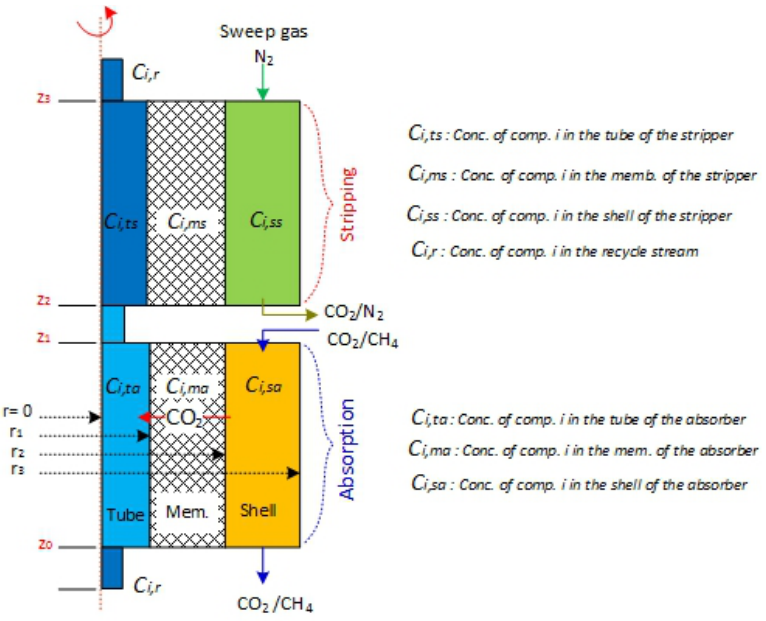
Figure 2. Schematic of the membrane module used in modeling the absorption/stripping system.